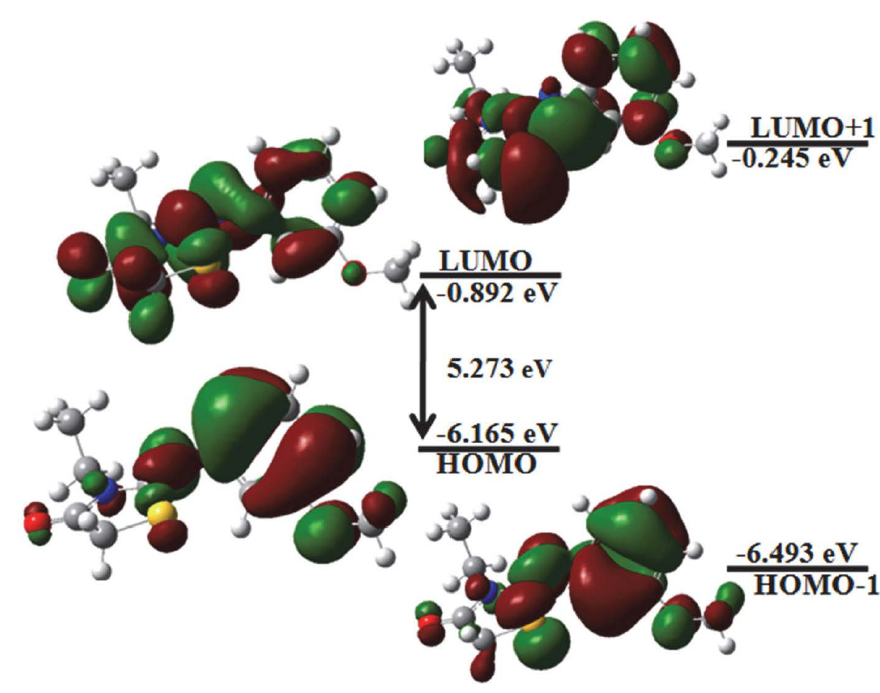
Figure 5. Electron distribution of the HOMO–1, HOMO, LUMO and LUMO+1 energy levels for the title